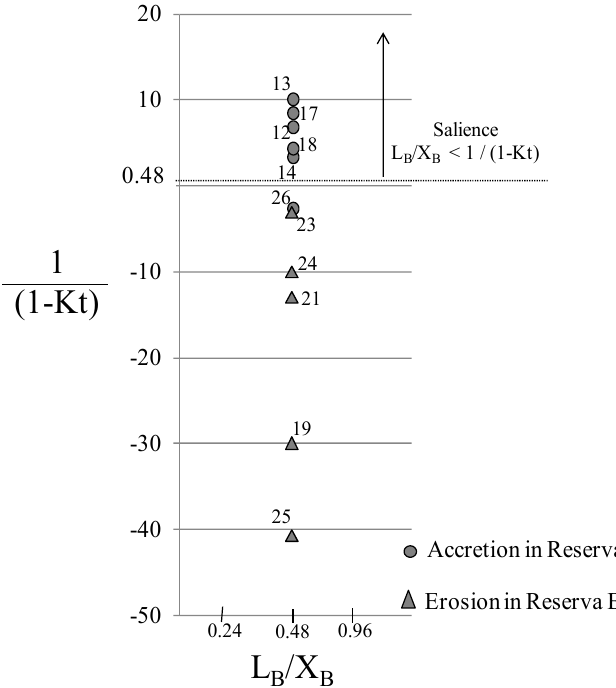
Figure 8. Results of the beach response model to a submerged coastal engineering model proposed by Pilarczyk [17].